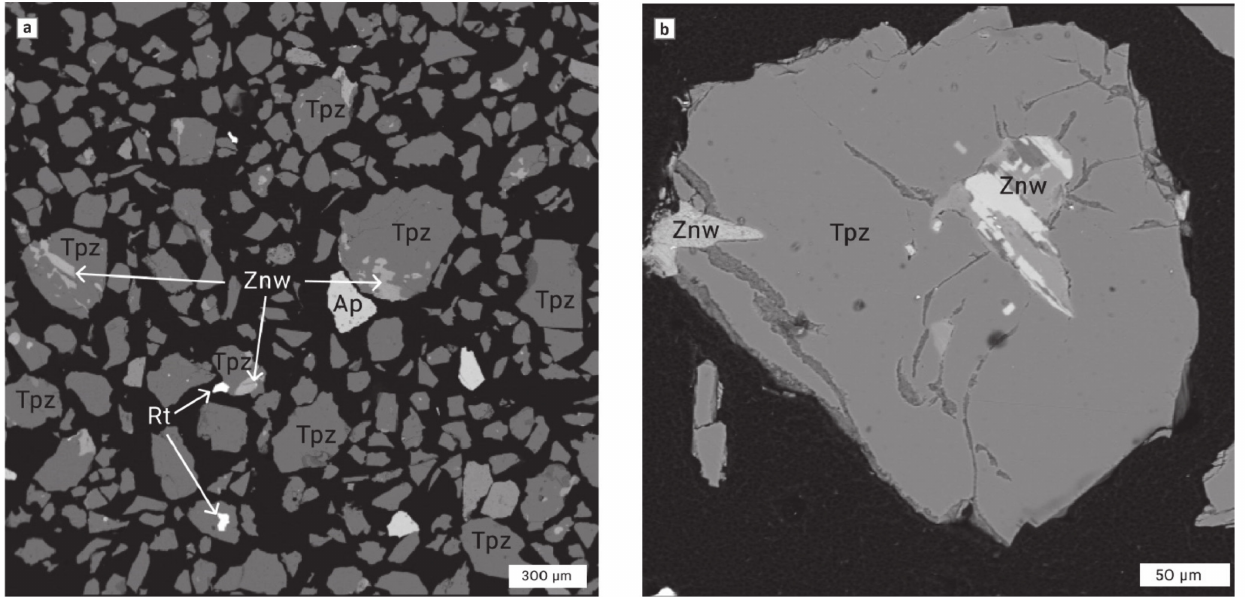
Figure 10. ( a ) SEM/EDS-BSE image of topaz concentrate and ( b ) topaz grain enclosing zinnwaldite (right). The topaz grain shows presence of distinct microfractures filled with kaolinite family clay mineral (probably dickite being associated with hydrothermal alteration of topaz [31]). Explanation: Tpz = topaz, Rt = rutile, Ap = apatite, Znw =